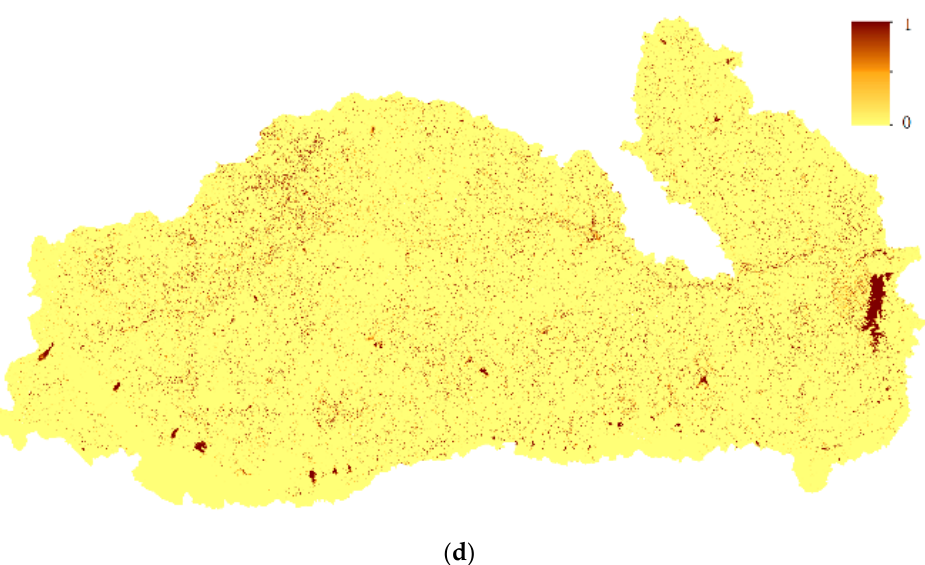
Figure 5. Fuzzy classification results and membership of selected land cover types in the Mun River Basin: ( a ) classification result by nearest neighbor; ( b ) membership of paddy rice; ( c ) membership of evergreen forest; ( d ) membership of water.